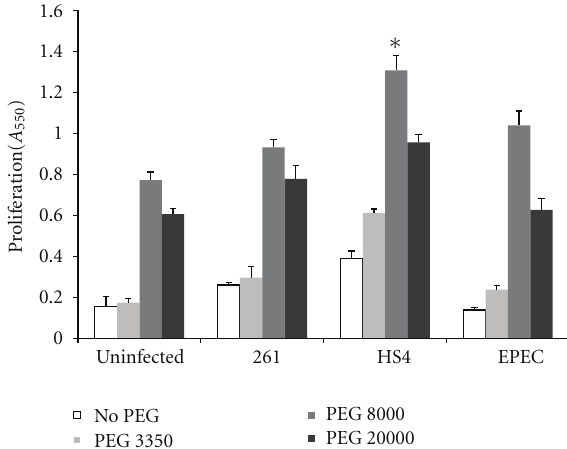
Figure 1: PEG 8000 increases proliferation of Caco-2. Proliferation of cells on the sca ff old was observed using MTT proliferation assay as described in Methods. Higher molecular weight PEGs, 8000 and 20,000, increased proliferation regardless of bacterial infection. Maximumproliferation was noted when cells were treated with HS4 and PEG 8000. Standard Student’s t -test was applied to the samples and P < 0 . 05 were obtained for samples treated with PEG 8000 and HS4 indicated by an asterisk ( ∗